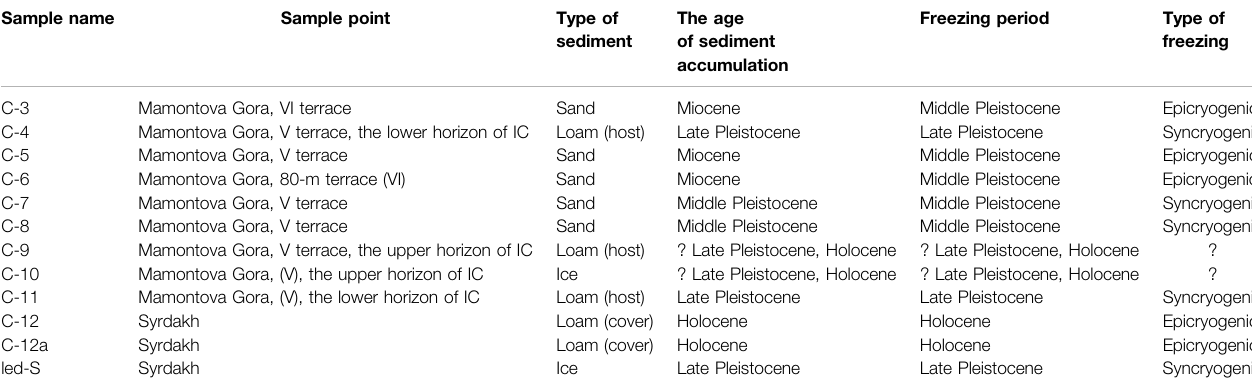
TABLE 1 | The list of samples for microbiological analysis of the outcrops of Mamontova Gora and